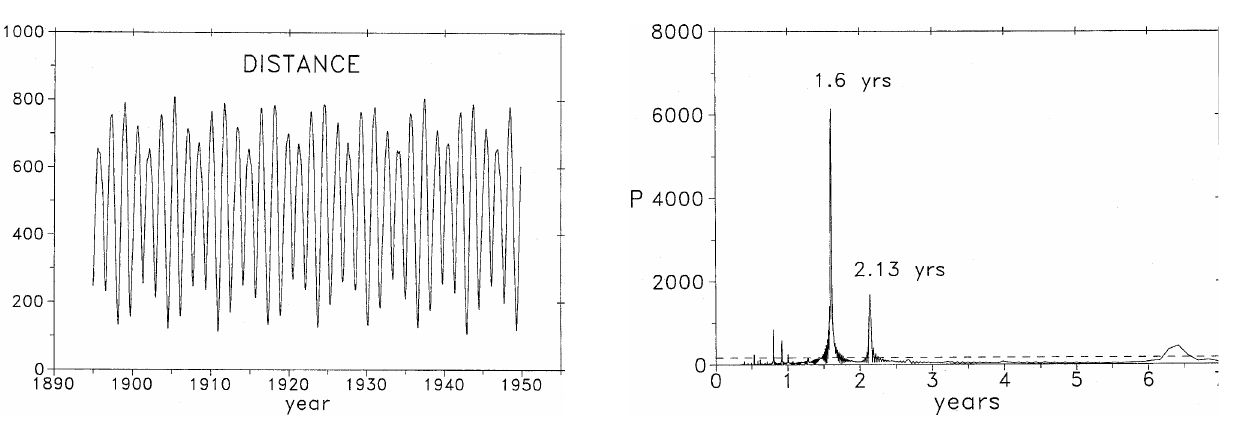
Fig. 3. The distance of the centre of the Sun created by the motion of the inner (terrestrial) planets in the years 1895–1950. The peaks occur after 1.6 years (584 days) (close to the moments of the oppo- sition of V and E), on the average. Notice that the each fourth min- imum (4 × 1.6 years (V-E)=6.4 years and 3 × 2.13 years (E-Ma)=6.4 years) is the deepest (see Fig. 4).